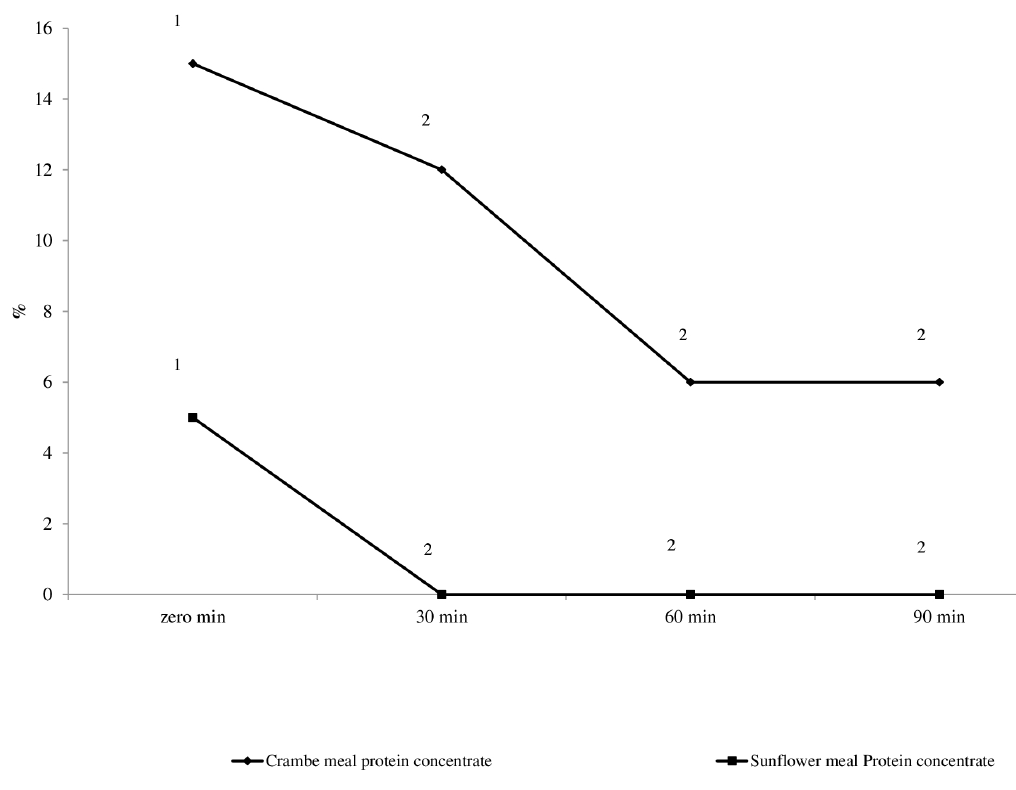
Figure 2 - The foaming properties of the protein concentrates derived from the crambe and sunflower meals.